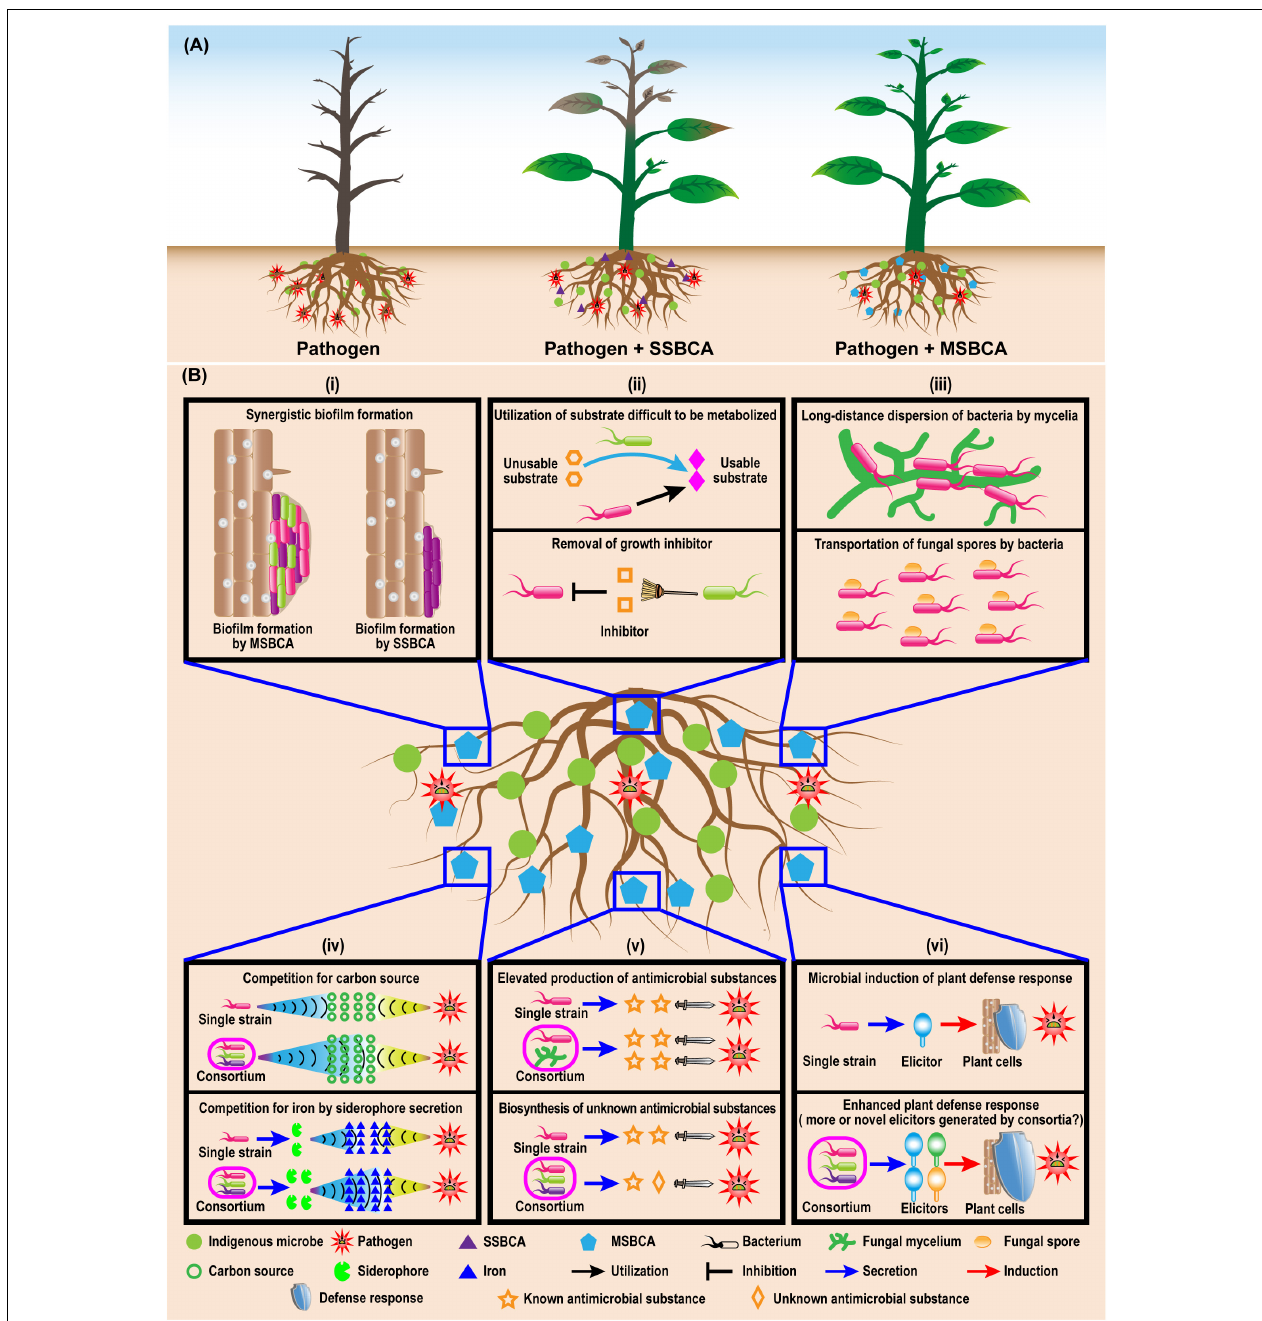
FIGURE 1 | Enhanced biocontrol effects of multiple-strain biological control agents (MSBCA) against soil-borne pathogen (A) and the potential mechanisms underlying the elevated disease-suppressive efficacy (B) . (i) enhanced biofilm formation, (ii) syntrophic microbial growth promotion, (iii) facilitated migration, (iv) boosted competition for resources, (v) stimulated antimicrobial substance biosynthesis, and (vi) elevated plant defense response